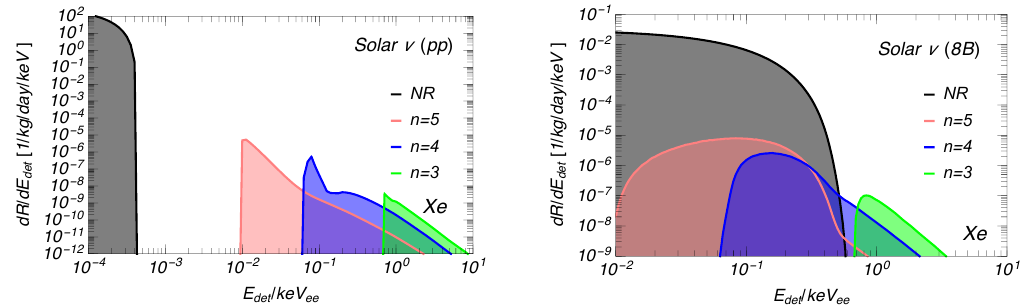
Figure 6 . The di(cid:11)erential event rates for expected for the coherent neutrino-nucleus scattering for the pp and the 8 B solar neutrinos. The single-phase liquid Xe detectors are assumed as in the previous section with q nr = 0 : 15. The black lines show the nuclear recoil (NR) spectrum without the ionizations. (The NR spectrum with respect to E det and the one with respect to E R di(cid:11)er by a factor of 1 =q nr .) Since we apply the estimations for the isolated atoms, the ionization spectrum from the valence electrons are not